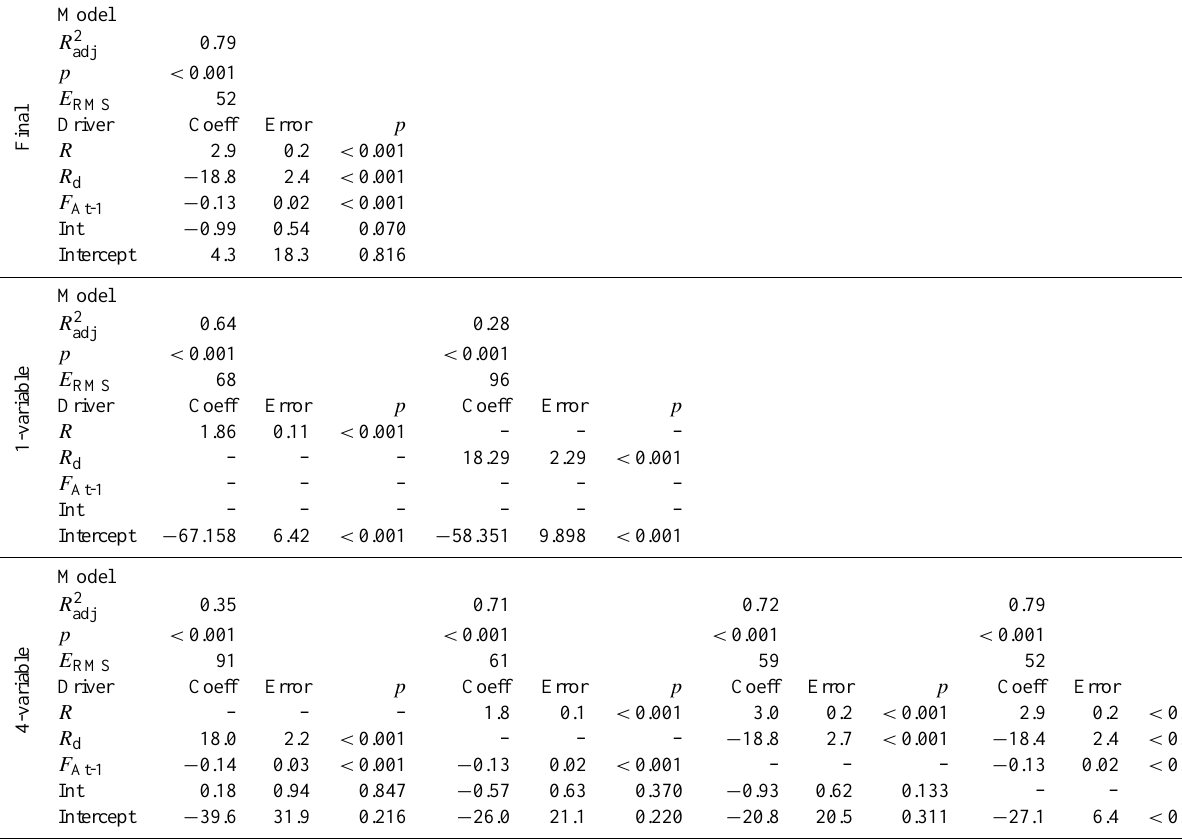
Table A4. Sensitivity analysis of the four variables included in the statistical